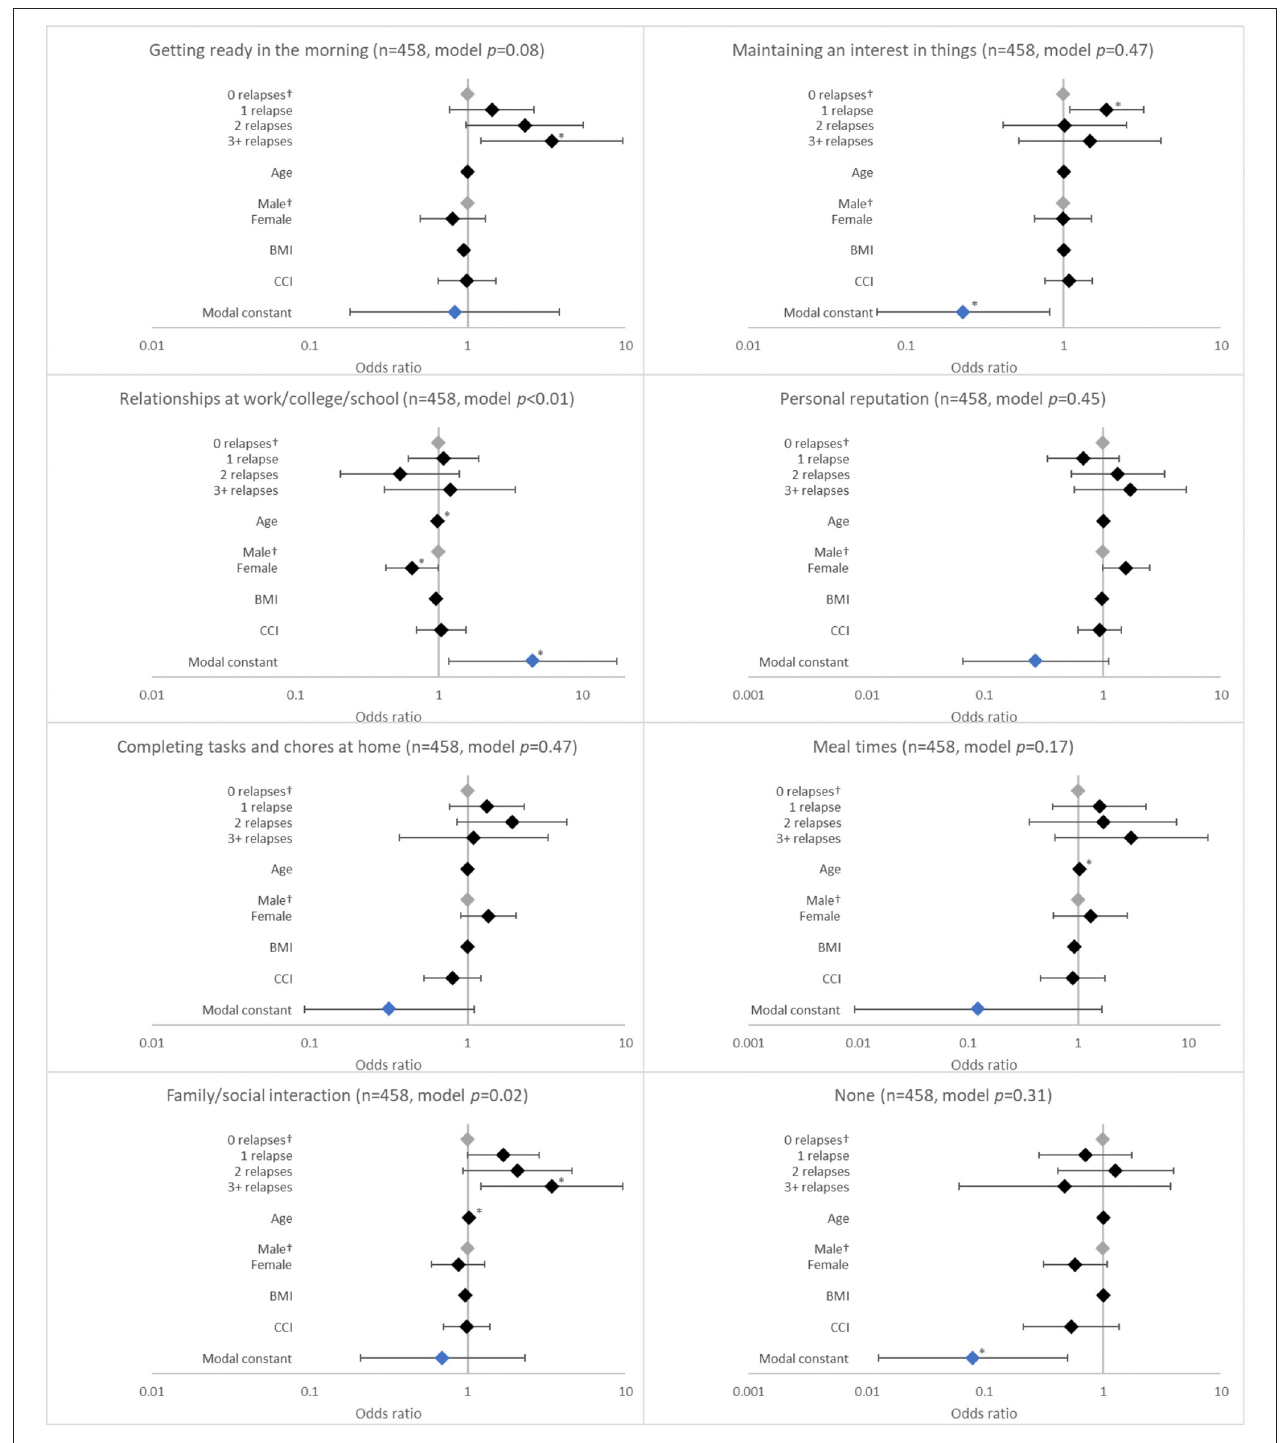
FIGURE 2 | Association between patient-reported social outcomes and the number of relapses in the last 12 months. † Base level, * p < 0.05 and ** p < 0.001. Likelihood ratio p -values are referenced in Table 2 . BMI, body mass index; CCI, Charlson comorbidity index. Grey diamonds indicate base level. Blue diamond indicates the model